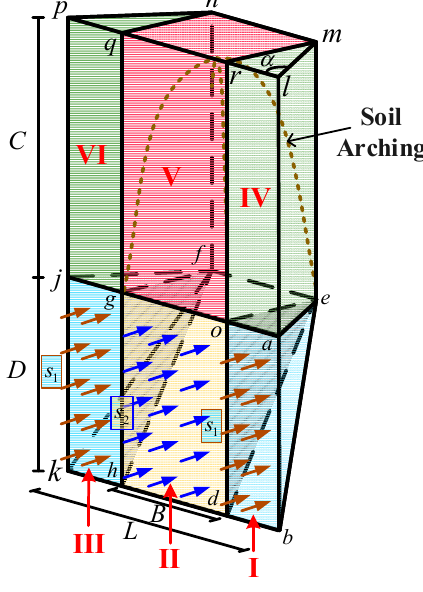
Figure 4. Modified model.